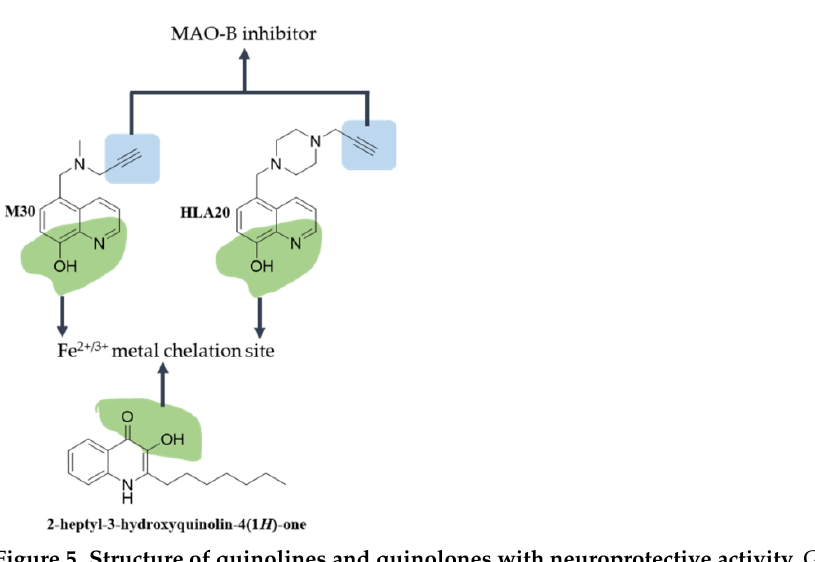
Figure 5. Structure of quinolines and quinolones with neuroprotective activity. Green shadowing shows iron chelation sites; blue shadowing shows MAO-B inhibition sites.